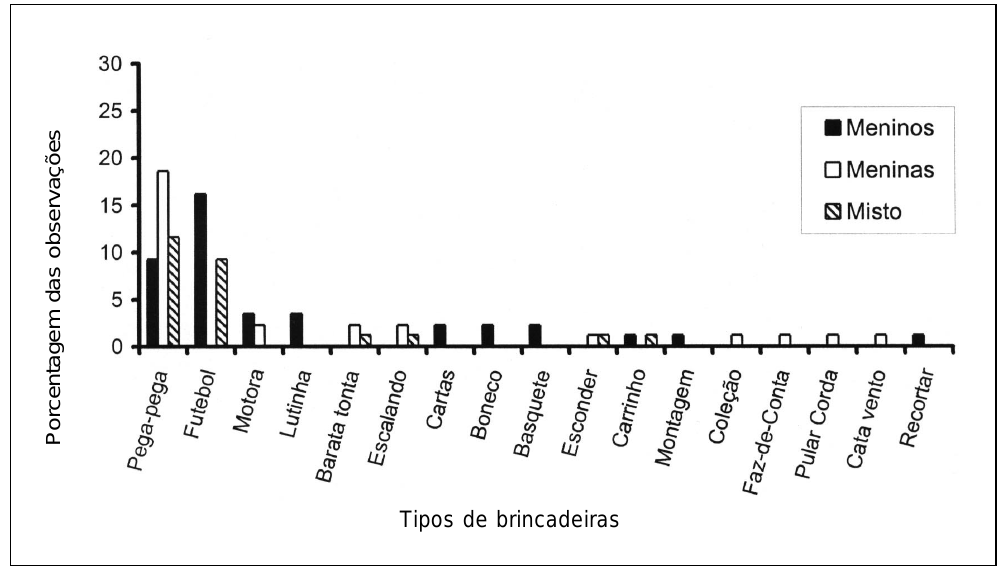
Figura 3. Tipos de brincadeiras e suas respectivas porcentagens, quanto ao gênero, observadas entre as crianças das 1 as e 2 as séries